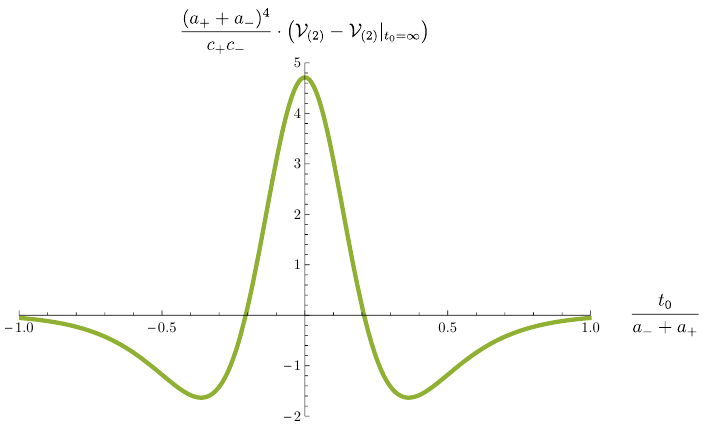
(^ g + ; ^ g (cid:0) ) for (2) ; mixed